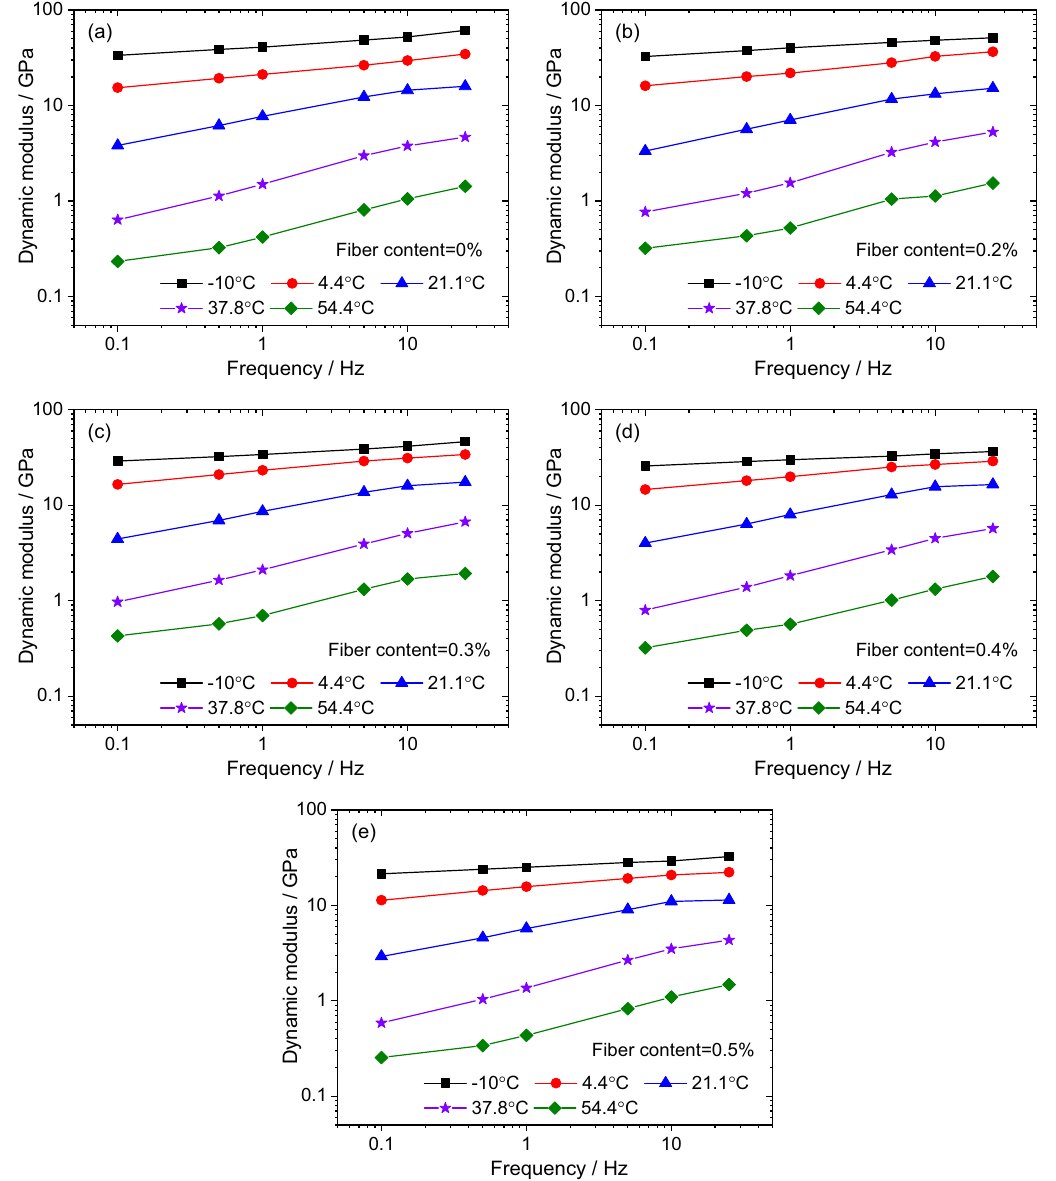
Figure 3: Variation of E ∣ ∣ ∗ with frequency at various temperatures for SBS - modi fi ed AC mixtures with basalt fi bers: ( a ) 0% fi ber, ( b ) 0.2% fi ber, ( c ) 0.3% fi ber, ( d ) 0.4% fi ber, and ( e ) 0.5% fi